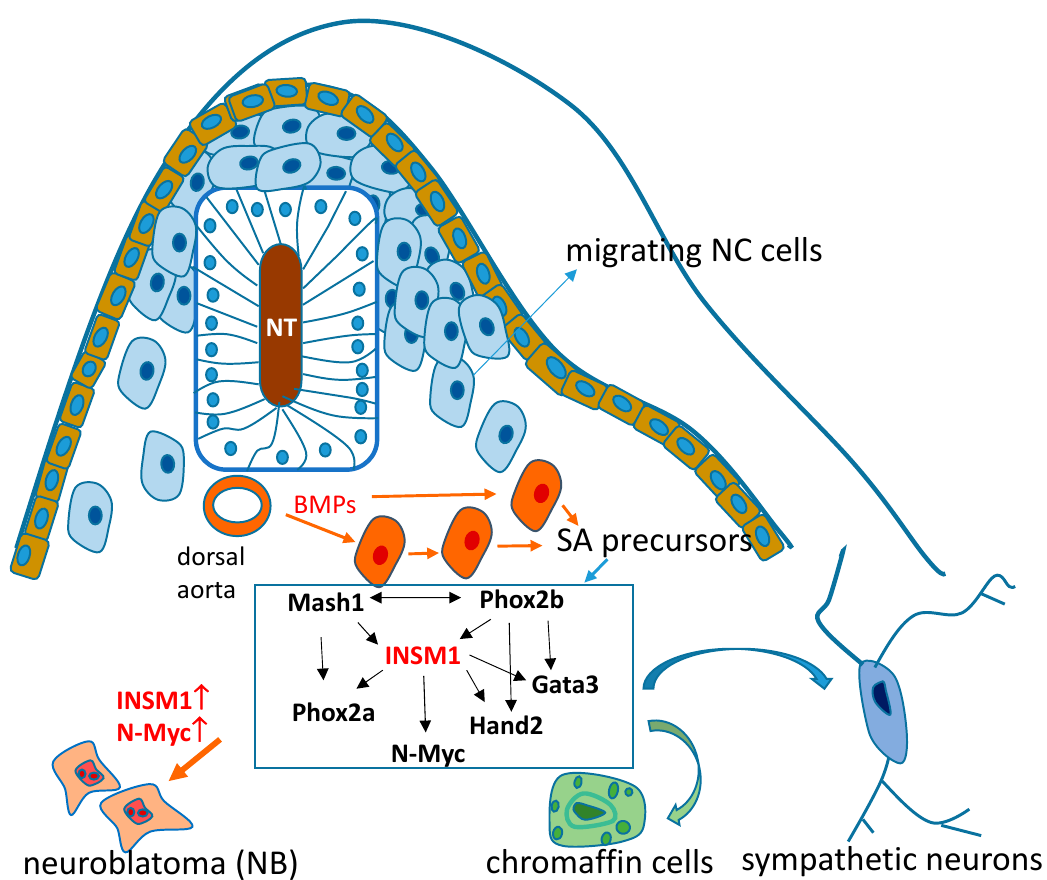
Figure 1. Role of INSM1 in SA lineage differentiation. Migrating neural crest (NC) cells from neural tube (NT) aggregated and stimulated by bone morphogenic proteins (BMPs) from the dorsal aorta wall for symphtho-adrenal (SA) progenitor cell differentiation. A common trans-regulatory network of specific transcription factors include Phox2b, Phox2a, Mash1 (Ascl-1), Hand2, Gata2/3, INSM1, and N-Myc, SA precursors further differentiate into sympathetic neurons and chromaffin cells, or NB tumor formation.